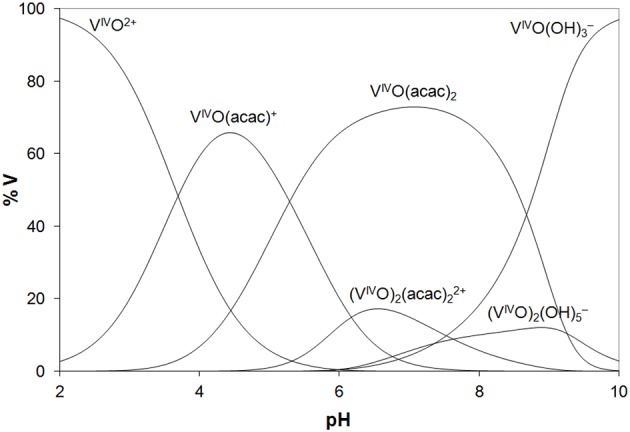
Distribution diagram of the species as a function of pH in a solution containing VIVO2+ ion and acac (VIVO/acac = 1/2, VIVO = 1.50 ×10−4 M). The stability constants of the VIVO–acac complexes were taken from Crans et al. (2001) and of the hydrolytic species from Buglyo et al. (2000).